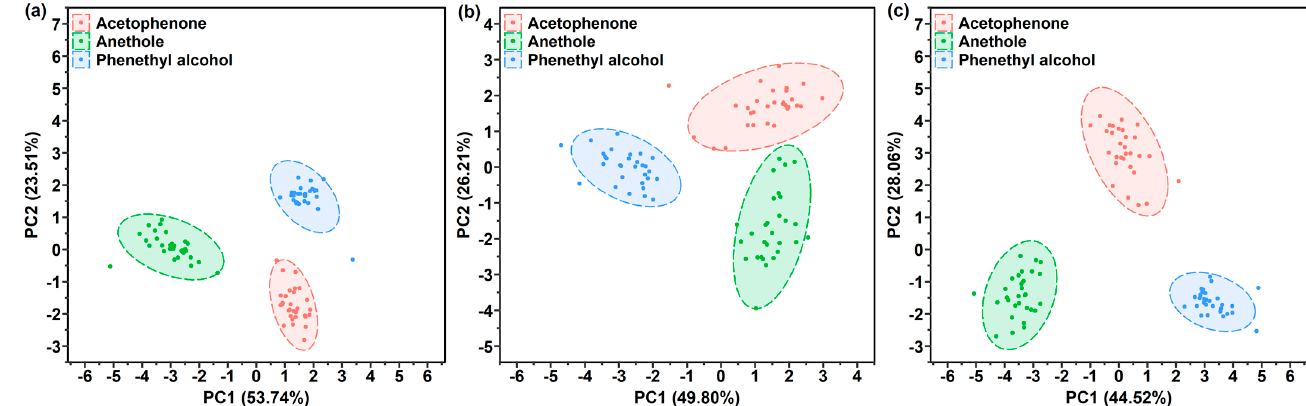
Figure 9. PCA score plots of the ( a ) 3 one-layer polymer film-coated SERS gas sensors, ( b ) 3 two-layer polymer film-coated SERS gas sensors and ( c ) 3 one-layer and 3 two-layer polymer film-coated SERS gas sensors used for phenethyl alcohol, acetophenone and anethole gases detection.